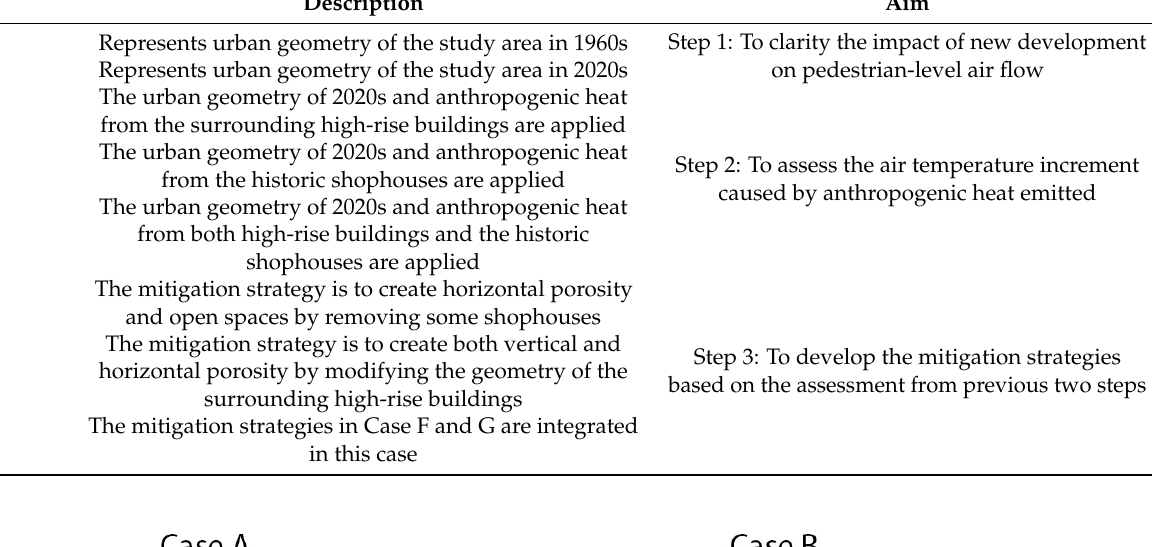
Table 1. Description of Case A-H and simulation aim of step 1–3.